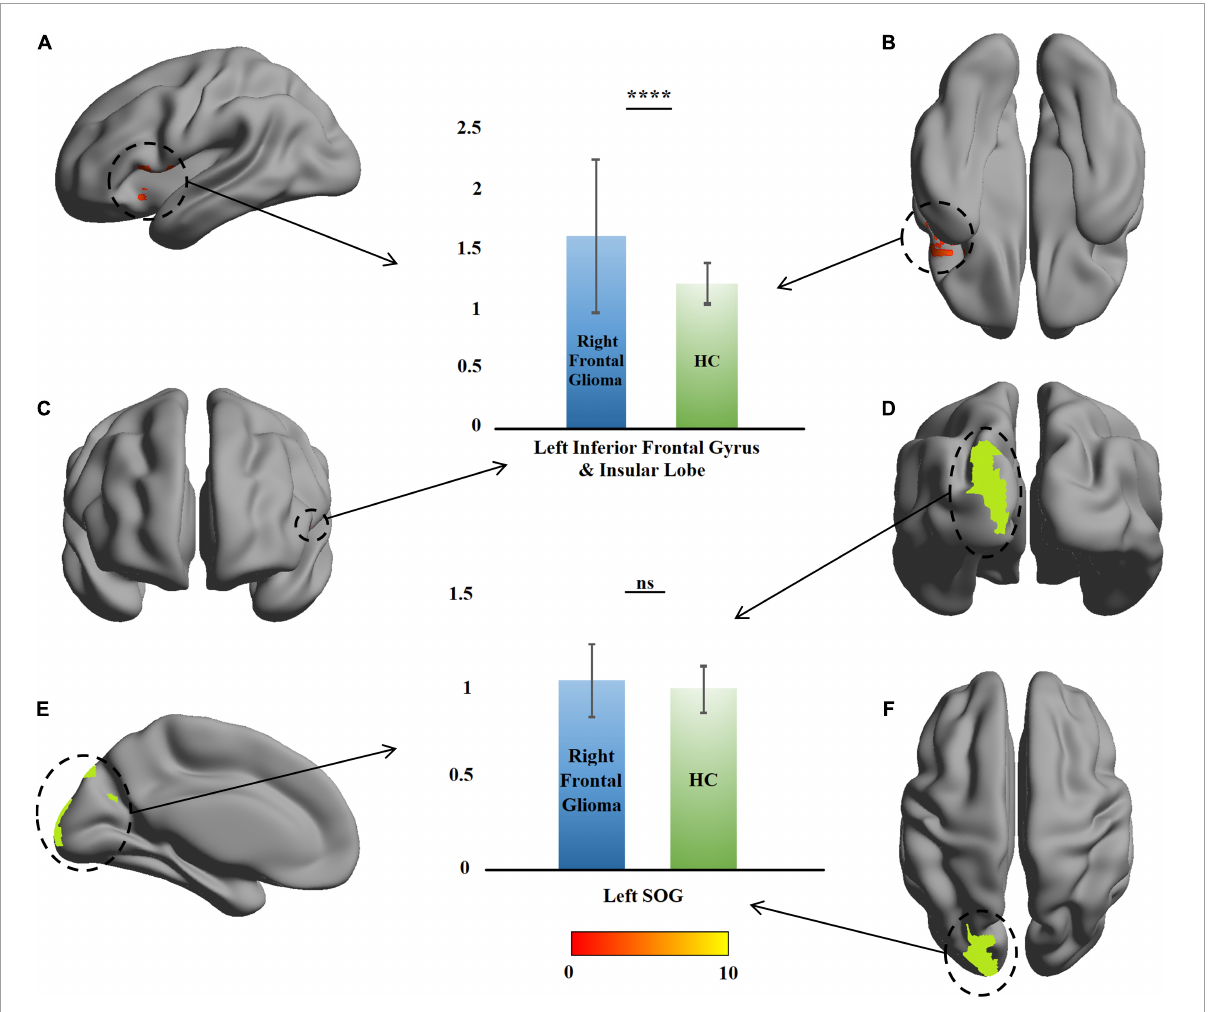
FIGURE4 Comparison of amplitude of low-frequency fluctuation between the patients with right frontal glioma and healthy controls (HCs). The warm colors (red to yellow) indicate the significant area (the right orbital gyrus and gyrus rectus) with the right frontal mean amplitude of low-frequency fluctuation (mALFF) indicated as the mask. Green color indicates the right superior occipital gyrus (SOG). The mALFF of the patients and HCs are presented as histograms. ns, not significant. **** P ≤ 0.0001. (A) Left view; (B) bottom view; (C) anterior view; (D) posterior view; (E) right view (only left cerebral hemisphere); (F) top